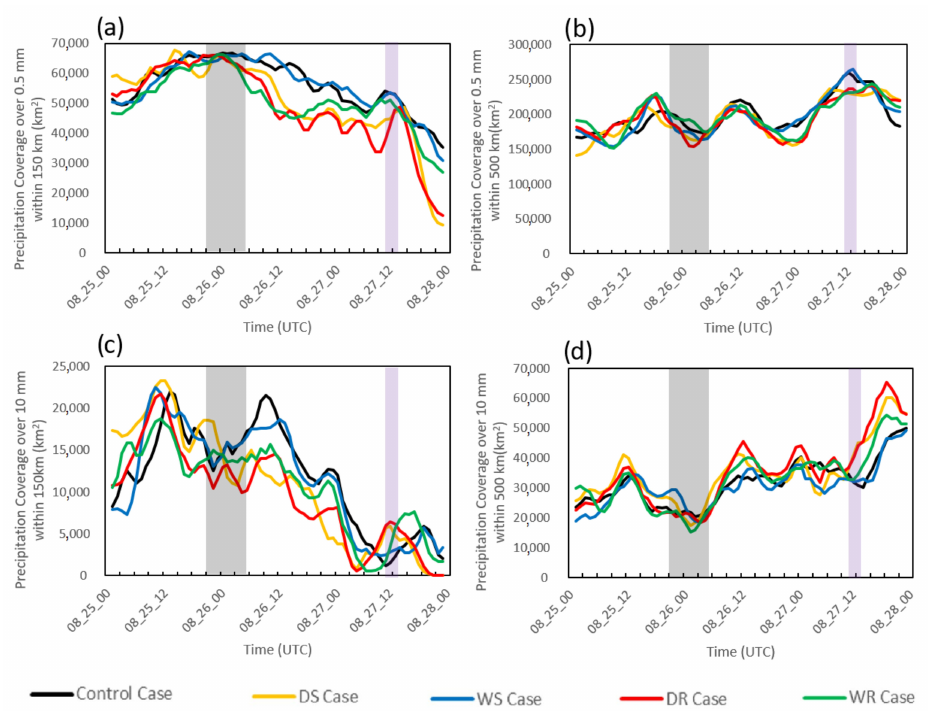
Figure 10. Precipitation coverage in km 2 for ( a ) hourly accumulation greater or larger than 0.5 mm within 150 km radius, ( b ) 0.5 mm over 500 km radius, and ( c ) over 10 mm with 150 km radius ( d ) over 10 mm within 500 km